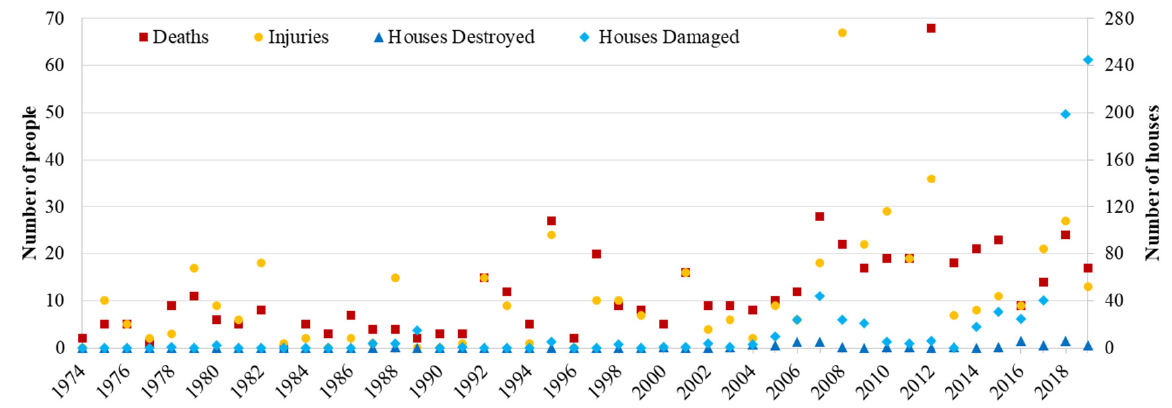
Figure 7. Annual variation of the lightning accidents in Sri Lanka, from 1974 to 2019.